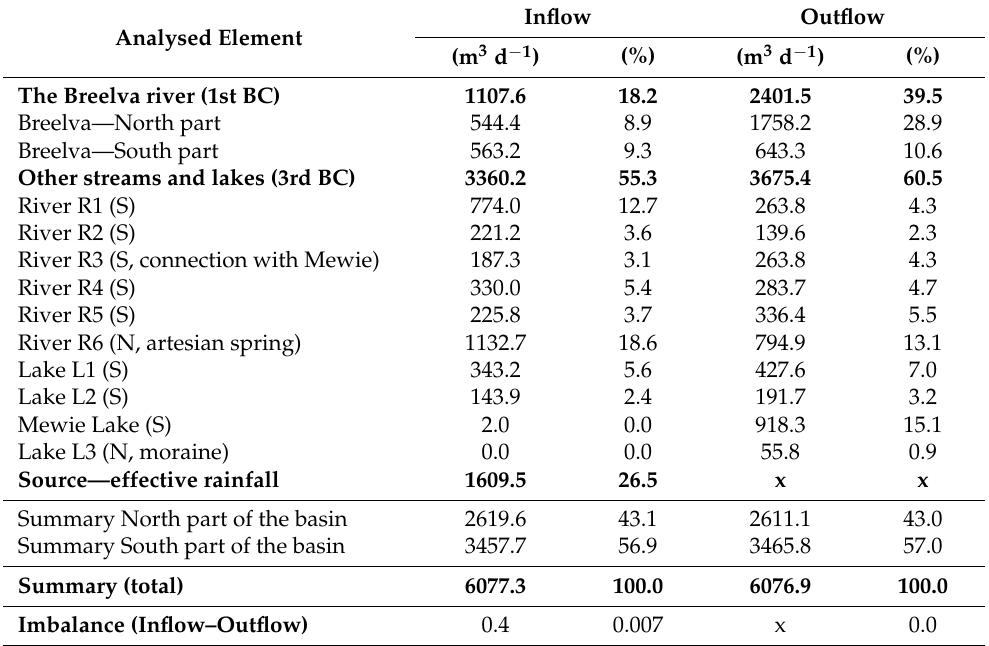
Table 4. Rate budget in FEFLOW. The locations of each object, i.e., rivers (R) and lakes (L), are marked in Figure 5. The border between the northern and southern parts of the catchment areas for summary calculations is the groundwater divide line, as shown in Figure